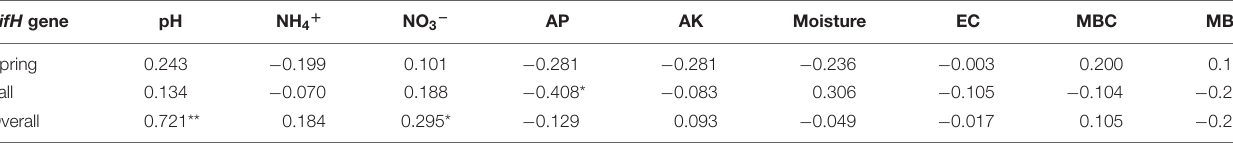
TABLE 1 | Correlation coefficients for relationships between nifH gene abundance and soil physicochemical properties.